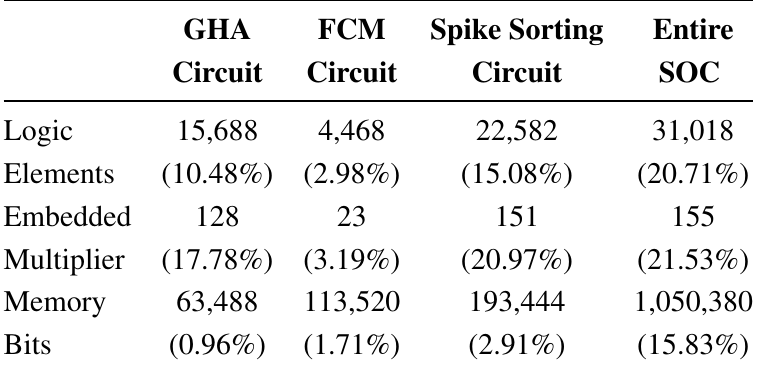
Table 6. Hardware resource utilization of the proposed spike sorting systems.